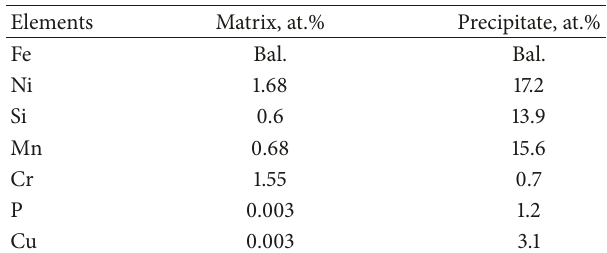
Table 4: The result of APT analysis of average composition of